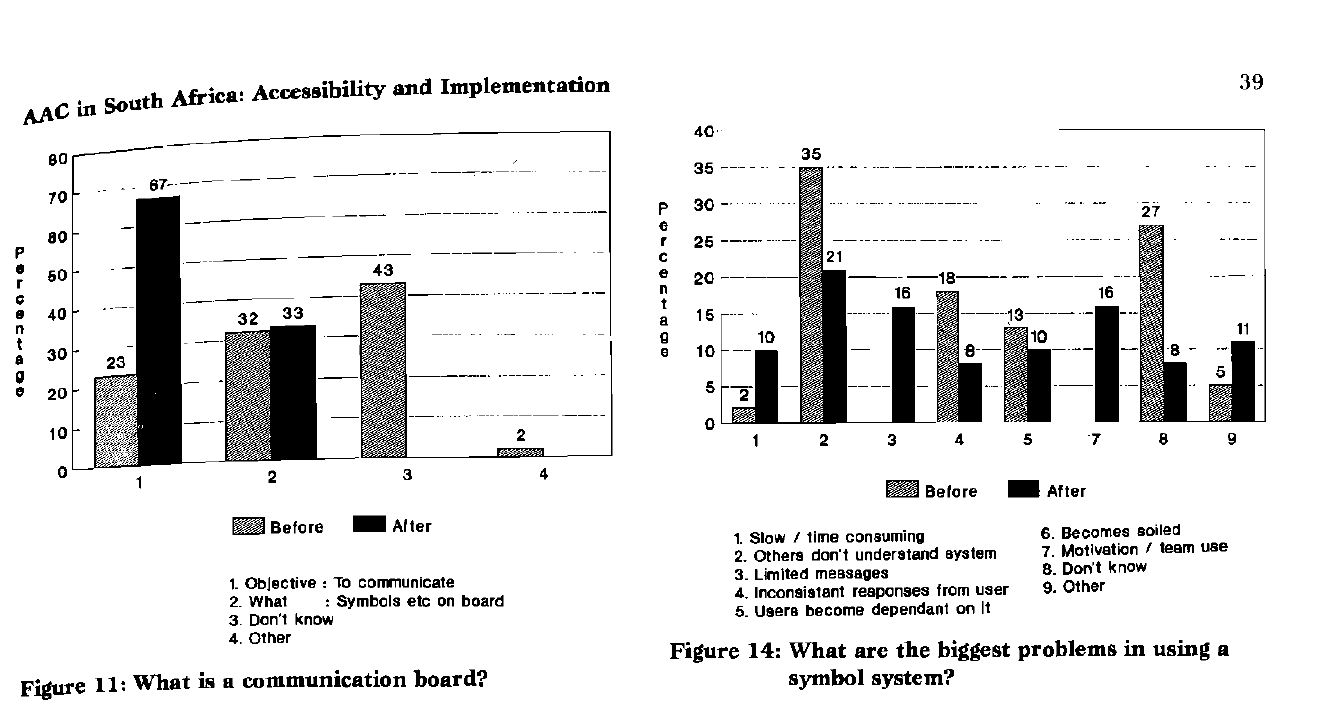
Figure 11: What is a communication hoard?